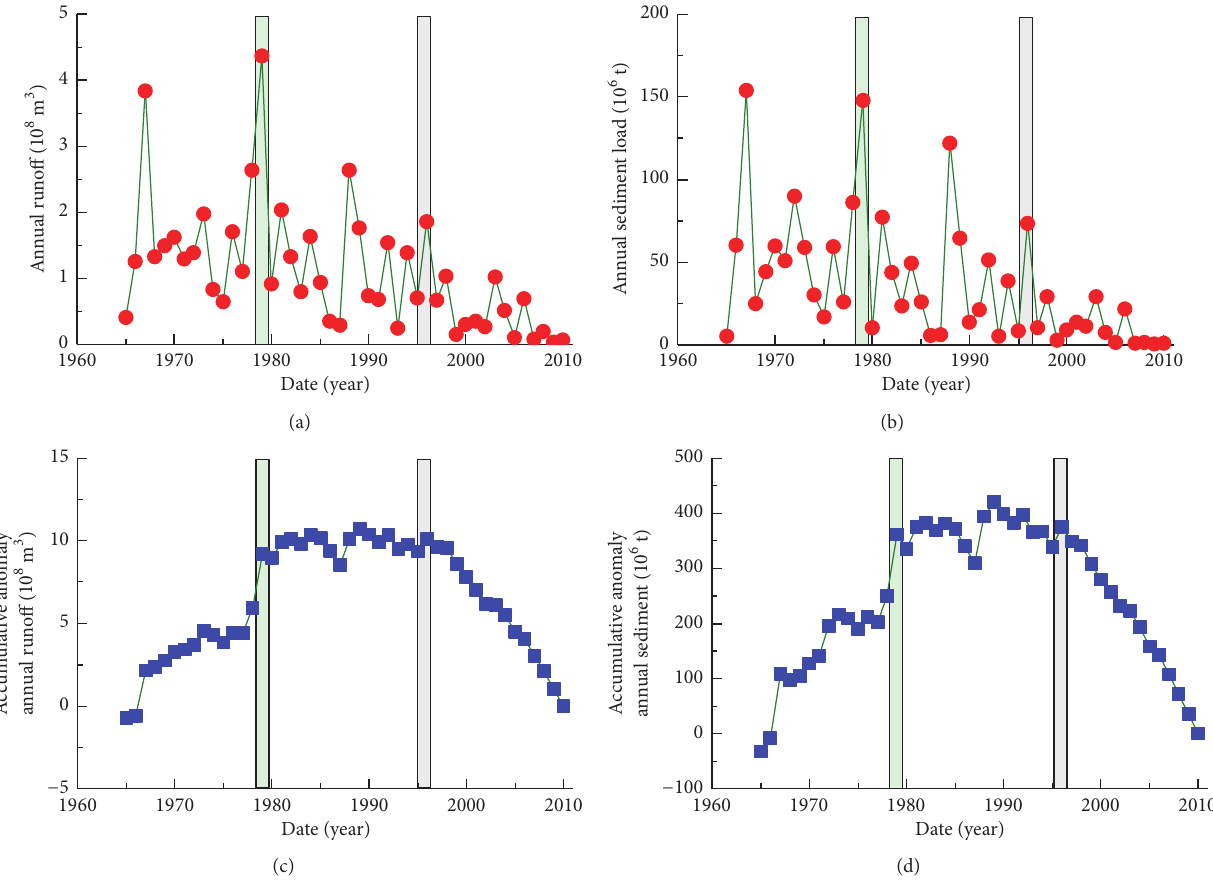
Figure 3: Variation in annual runoff and sediment load at Huangfu station ((a), (c) annual runoff changes and cumulative anomaly test; (b), (d) annual sediment load changes and cumulative anomaly